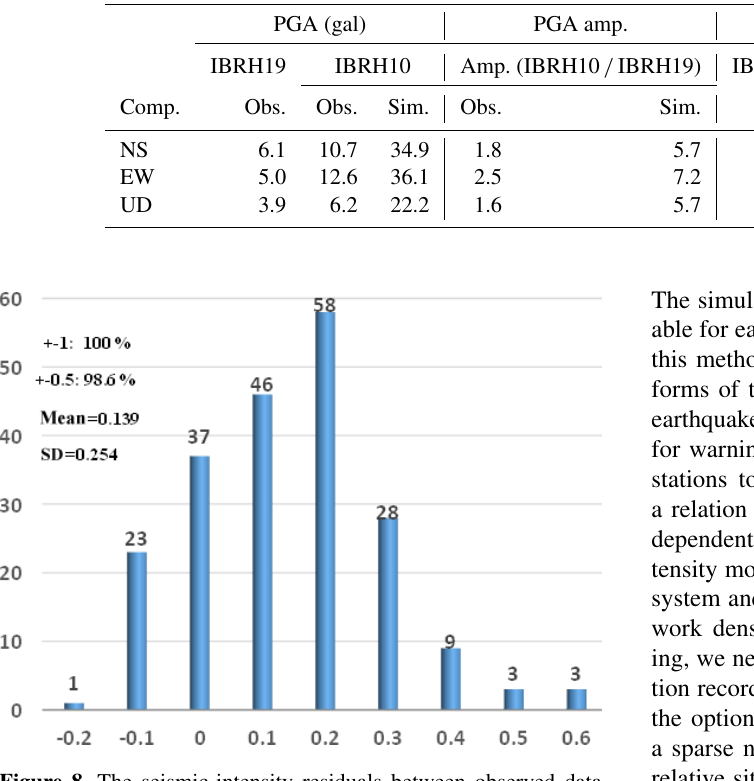
Figure 8. The seismic-intensity residuals between observed data and simulated